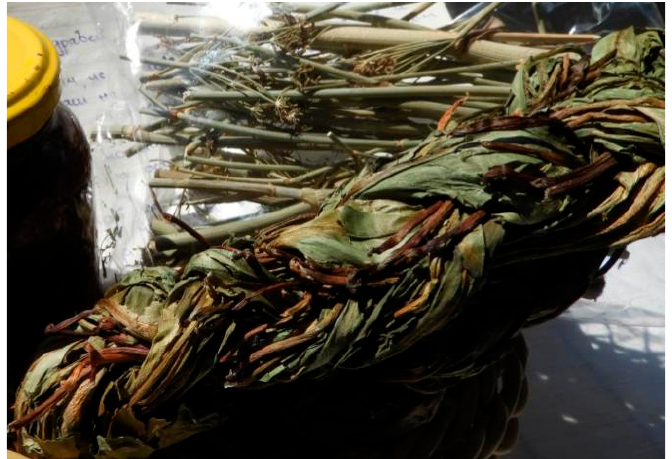
Figure 4. Dried Arum maculatum (snake dock, zmiyski lapad in Bulgaria) from Sliven province used for preparation of beef stews.